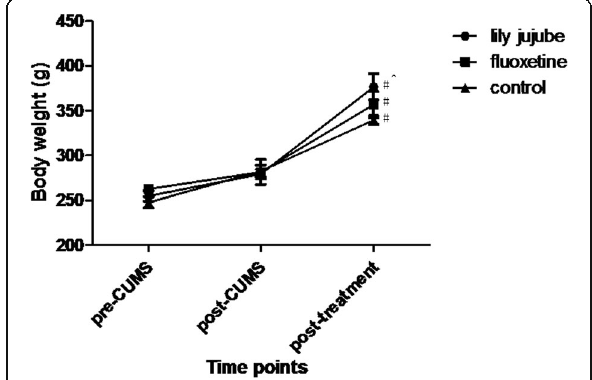
Fig. 2 Changes of body weight at different time points. Note: # < 0.05 compared within group with post-CUMS; ^< 0.05 compared with the control